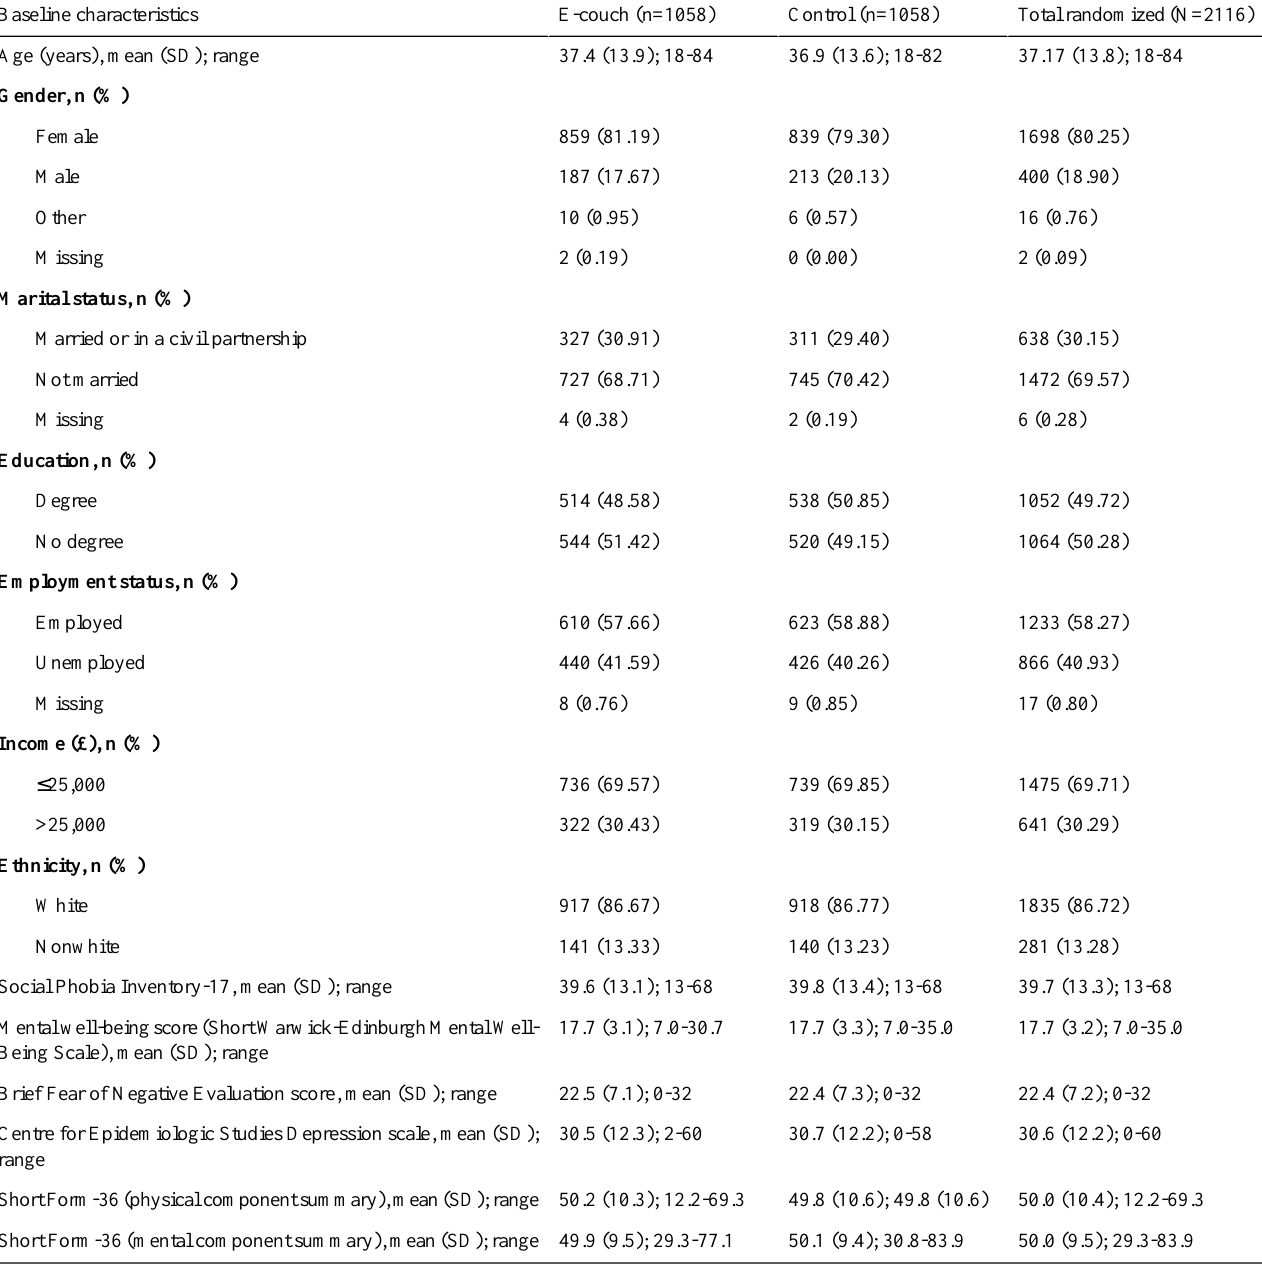
Table 1. Baseline characteristics of all participants